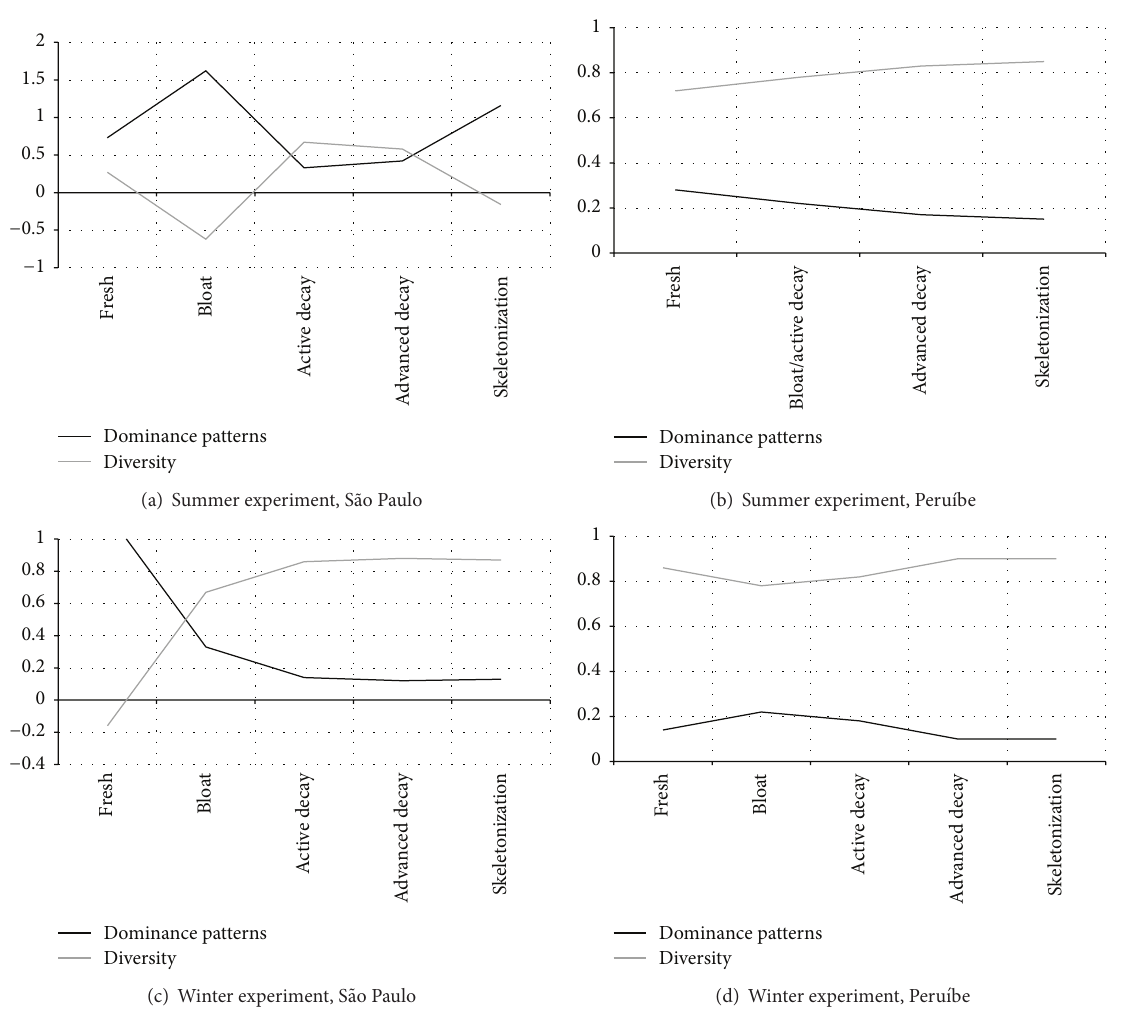
Figure 4: Graphical comparison of the Simpson dominance and diversity